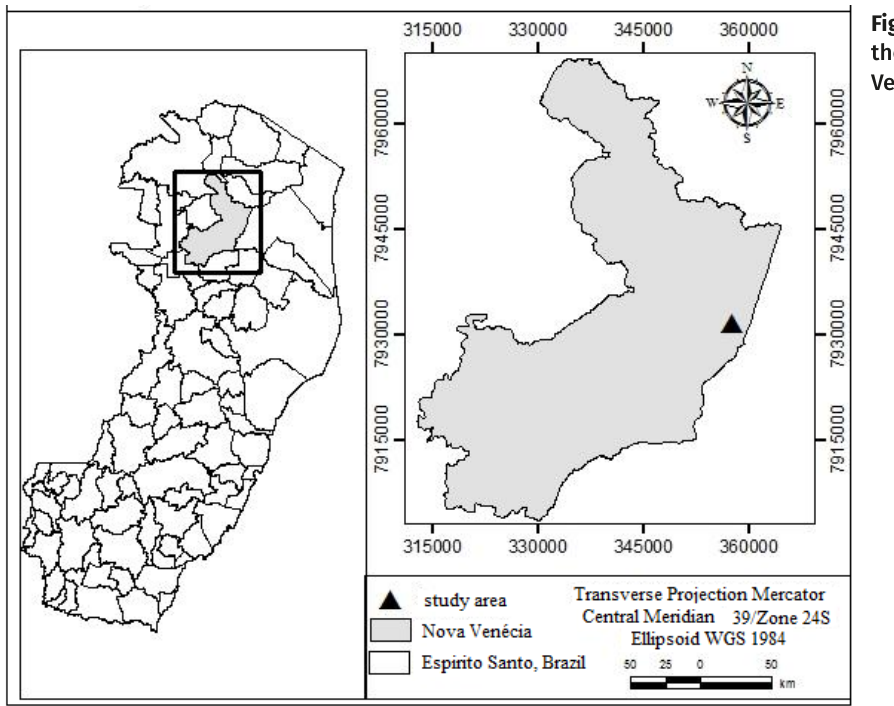
Figure 1. Location of the study area in